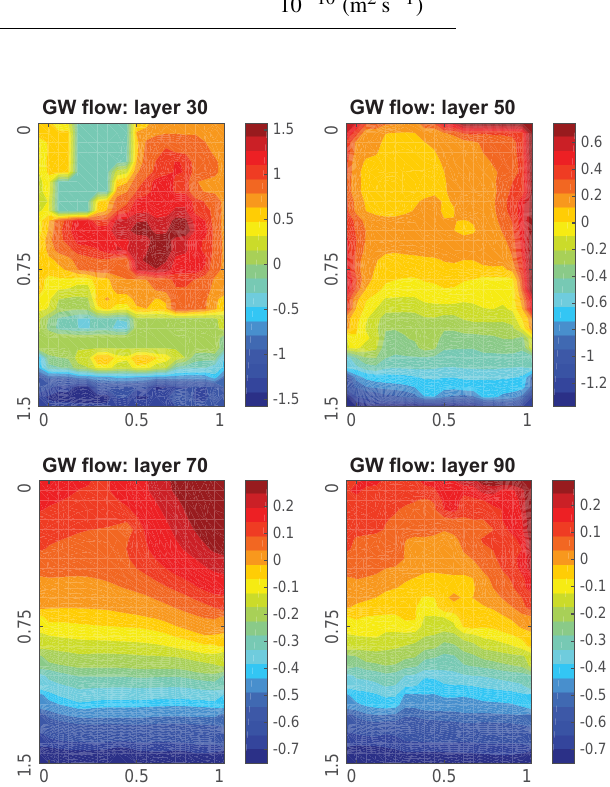
Figure 3. Groundwater (GW) hydraulic head configuration from four different active layers in the domain. The largest water head is located in the center of the domain and is equal to 1.5m. The water head deceases in the southern part of the domain. The flow is computed using MODFLOW and plotted using iMOD’s graphical interface